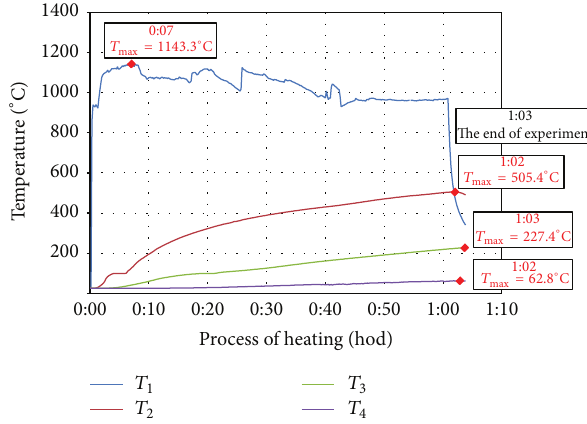
Figure 4: Record of thermal development of the test specimen CEM III/B - B-SF.